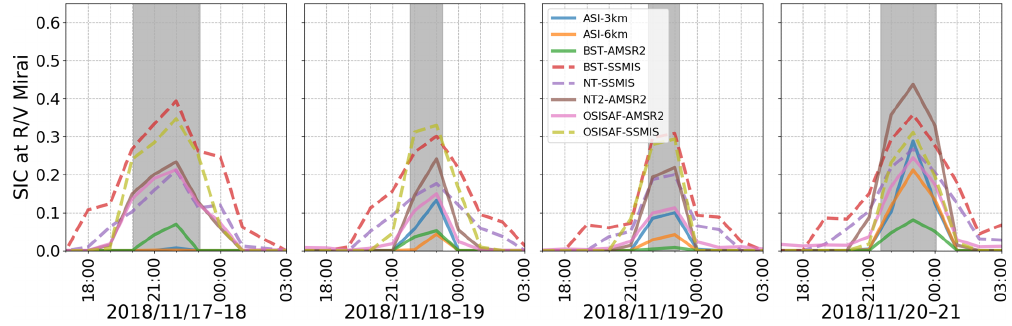
Figure D4. Satellite-retrieved SIC for all products along the R/V Mirai track during phases 3 and 4 between 17 and 20 November 2018. The figure schematics follow Fig.